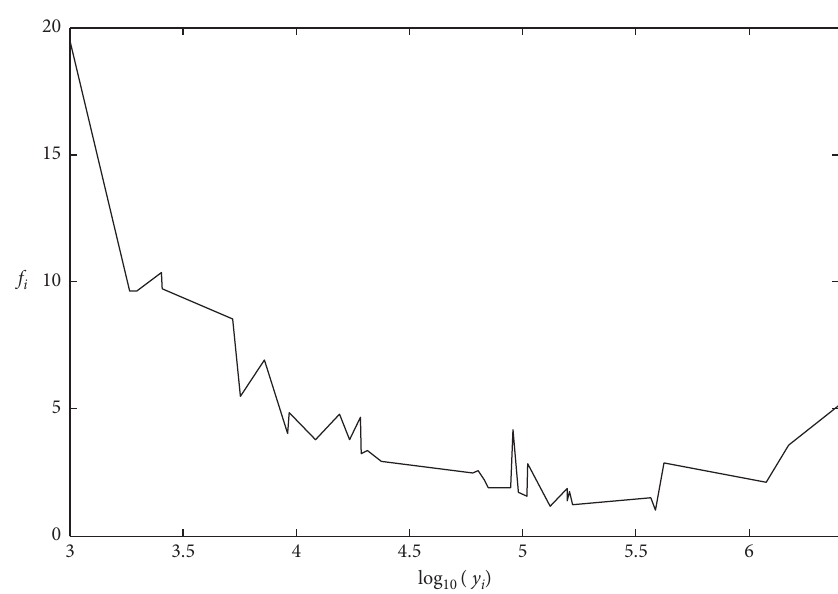
Figure 9: Evolution of average f